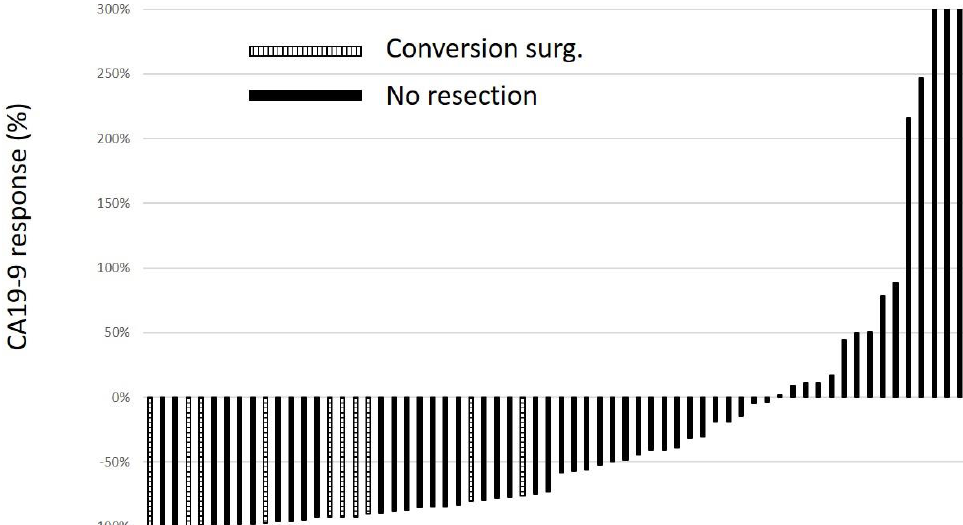
Figure 5. Waterfall plot of serum CA19-9 response from baseline for primary treatment. The data represent the rate of CA19-9 response, calculated as [(post treatment value/baseline value) − 1] (%). All patients were within normal CA19-9 levels of pretreatment; patients for whom CA19-9 levels were evaluated only once were excluded. Peritoneal washing cytology specimens were examined each month in patients in the i.p.-PTX group who had a peritoneal access port. Peritoneal washing cytology became negative in 24 of 43 patients (56%). Patients were categorized into five groups based on the time peritoneal cytology results becoming negative (<2 months: n = 1 4; ≥2 months to <3 months: n = 6 ; ≥3 months to <4 months: n = 3 ; ≥4 months to <6 months: n = 1; and peri- toneal cytology remaining positive) (Figure 6). Peritoneal cytology results became nega- tive within 4 months in all patients who underwent conversion surgery. Table 3 clearly reveals that i.p.-PTX therapy, CA19-9 normalization, and CR or PR rate by RECIST were significant predictive factors for conversion surgery. Table 3. Univariate and multivariate analysis to predict conversion surgery. Variables